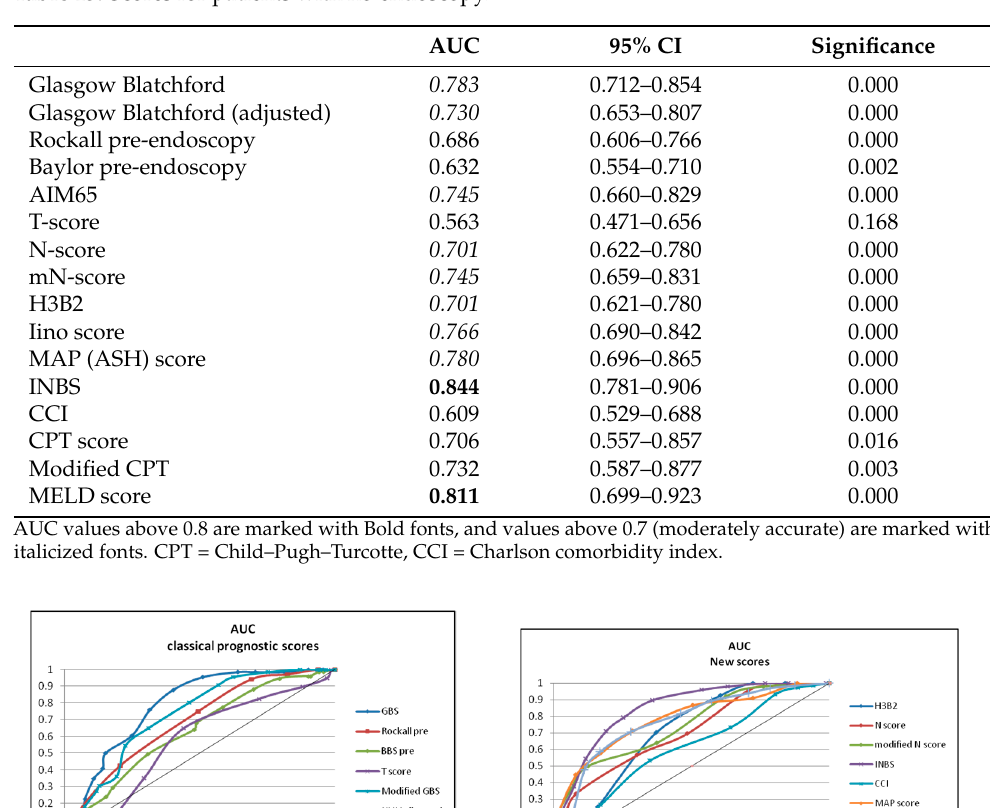
Table 13. Scores for patients with no endoscopy.